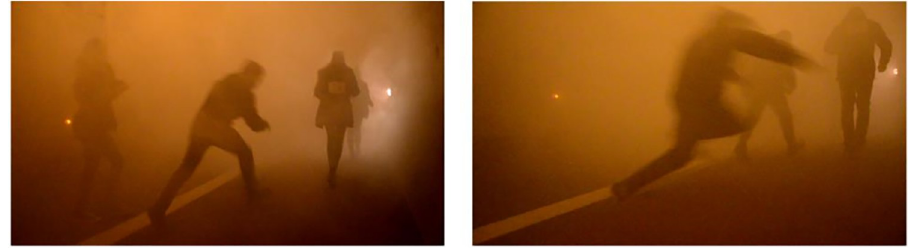
Fig 20. Examples of participants tripping on the curb and falling during Experiment 4 in